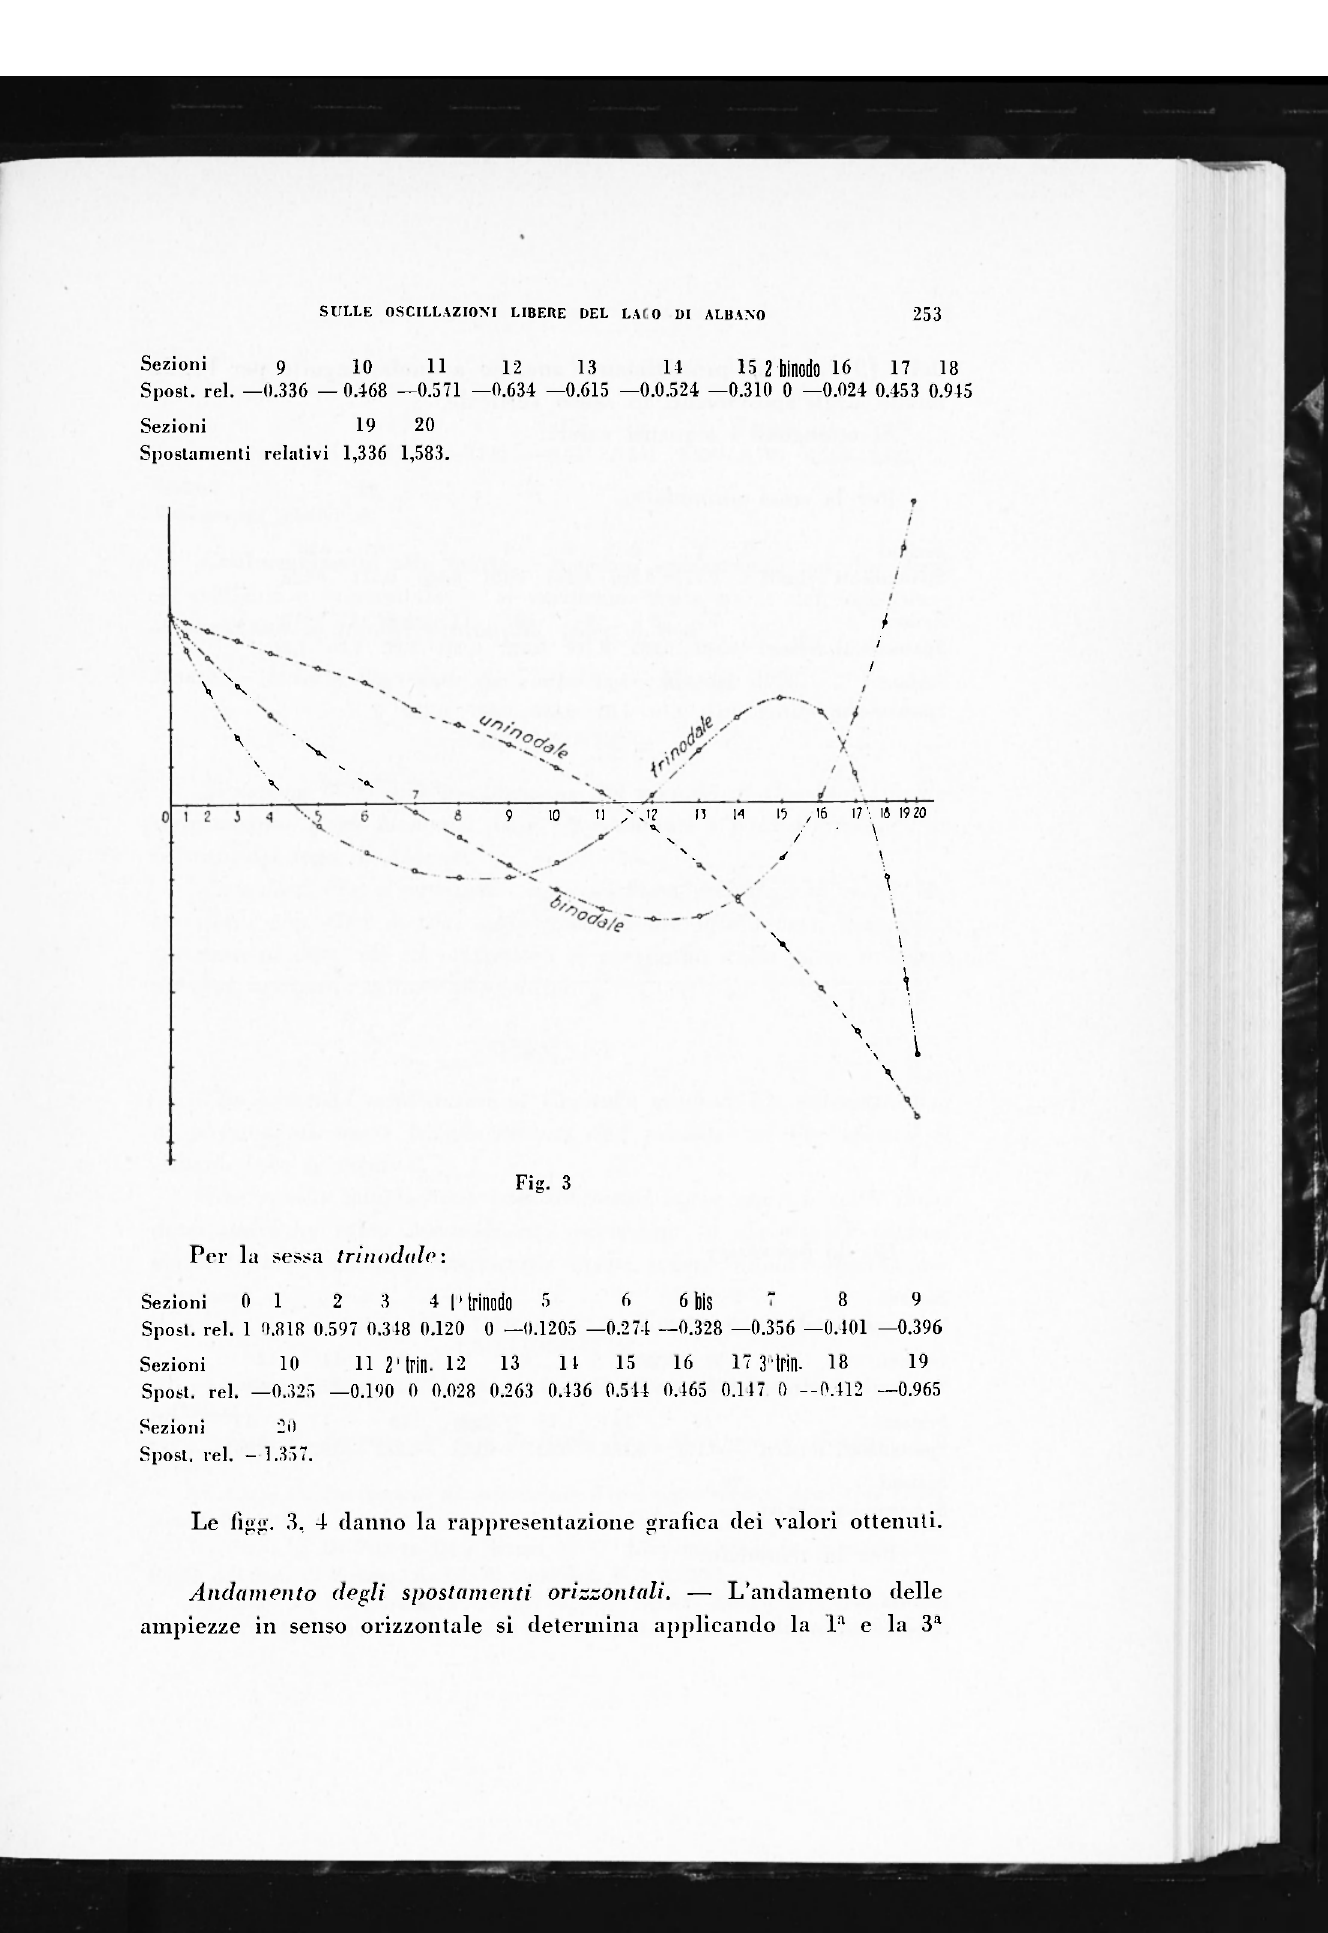
Le figg. 3, 4 danno la rappresentazione grafica dei valori ottenuti. Andamento degli spostamenti orizzontali. — L'andamento